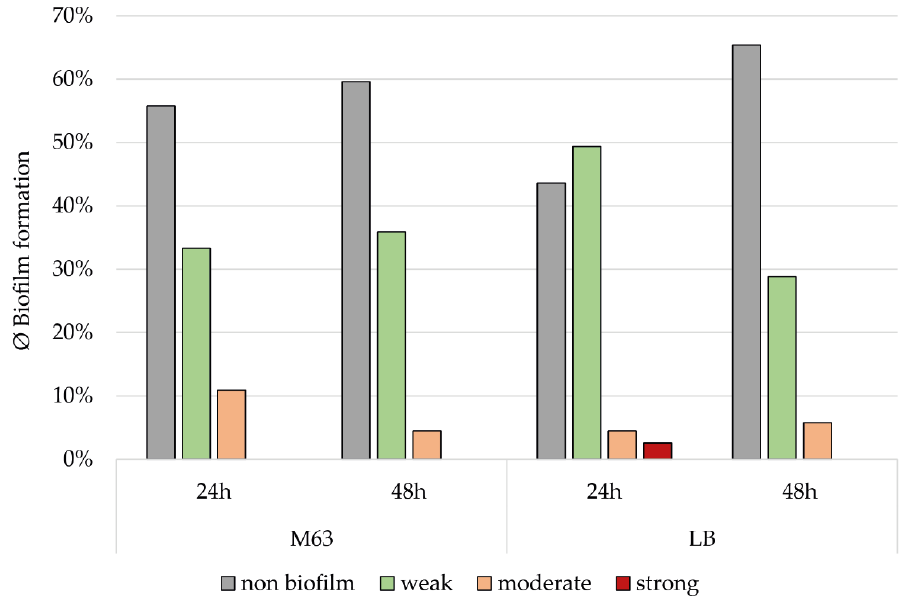
Figure 2. Occurrence of the individual classes (non-biofilm, weak, moderate, and strong) among 78 equine A. baumannii isolates in LB and M63 media after 24 or 48 h of incubation. Comparison of the two media at the same incubation time point revealed a significant difference in biofilm formation (for both, p < 0.001). However, within the same medium, there was no significant difference between the incubation times (LB: p = 0.579; M63: p = 0.087).